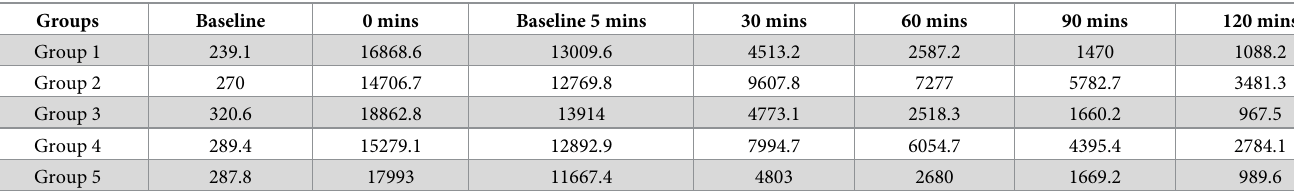
Table 1. Average small particle counts detected at different time